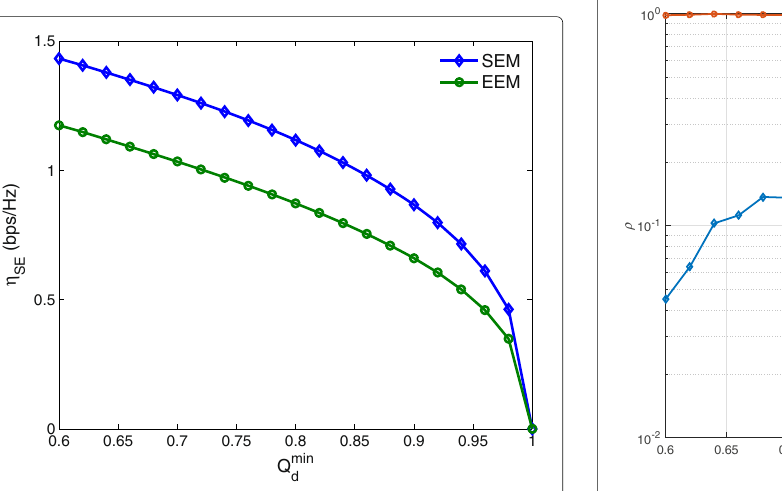
Fig. 6 Power utilization ratio comparison with detection